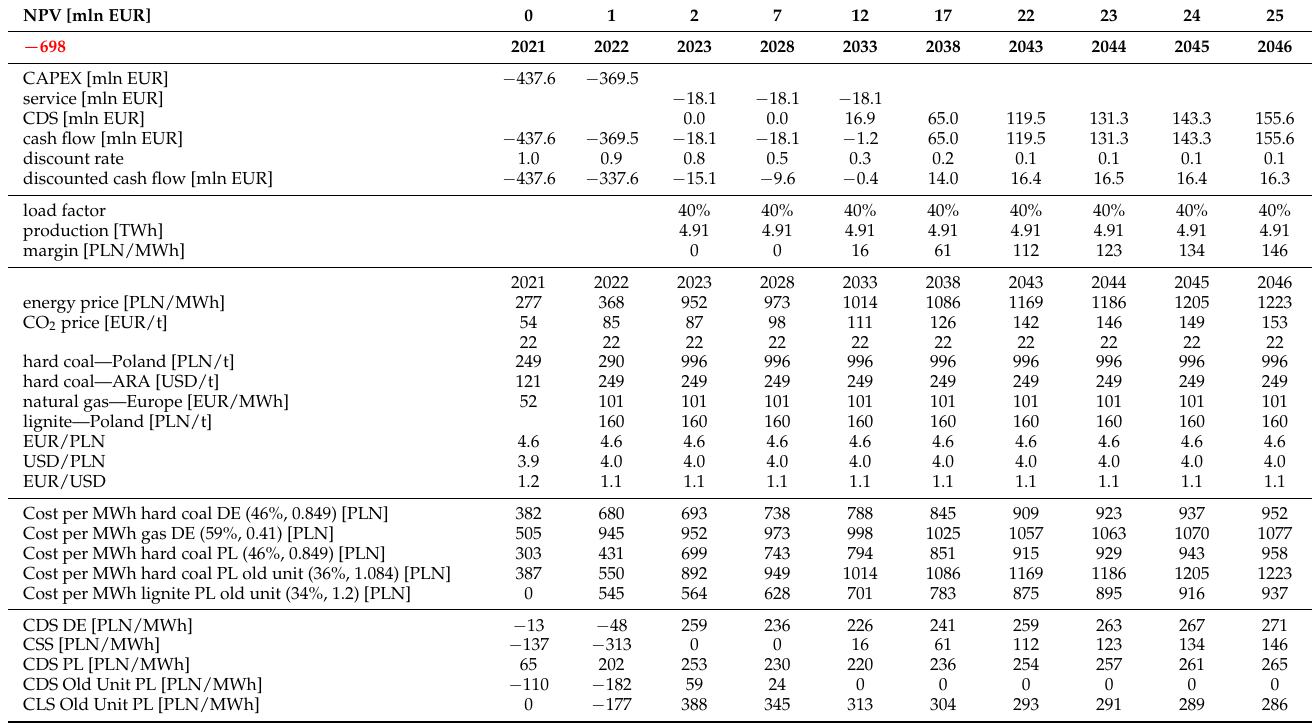
Table 4. Third scenario (source: created by the authors in